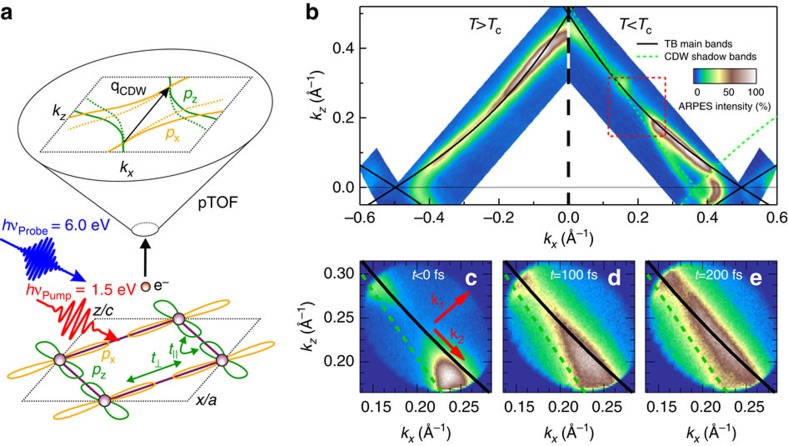
Time-dependent Fermi surface map.(a) Experimental scheme and TB model. The Te-5px/z orbitals in the Te-layers of RTe3 (bottom) are coupled by t|| and t⊥ describing interactions parallel and perpendicular to the Te chains and lead to a diamond-shaped Fermi surface in reciprocal space, which we excess by our position-sensitive time-of-flight photoelectron spectrometer (pTOF) (top). Nesting leads to shadow bands translated along qCDW (dashed lines). (b) Static FS of HoTe3 for T=300 K>Tc (left) and T=180 K<Tc (right). Main and shadow TB bands are indicated by solid and dashed lines, respectively. In the CDW phase, energy gaps open on the Fermi surface where main and shadow bands overlap. The red square indicates the region investigated in panels (c–e). (c–e) Time-dependent FS of DyTe3 for various pump-probe delays at T<Tc. The gapped FS transforms within 200 fs into a continuous, metallic state. Arrows in c indicate directions perpendicular (k1) and parallel (k2) to the FS, respectively. The weak intensity in the upper left corner in c stems from a partially twinned crystal domain.